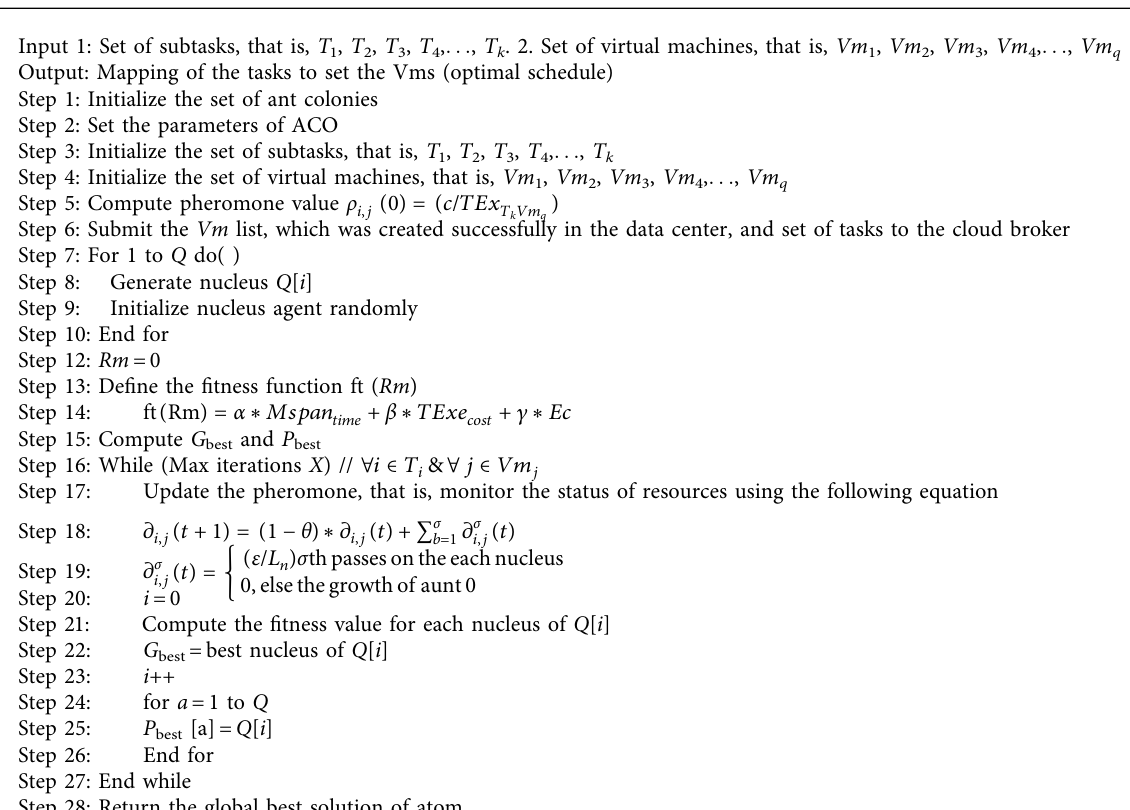
A LGORITHM 1: Hybrid ES-ACO task scheduling